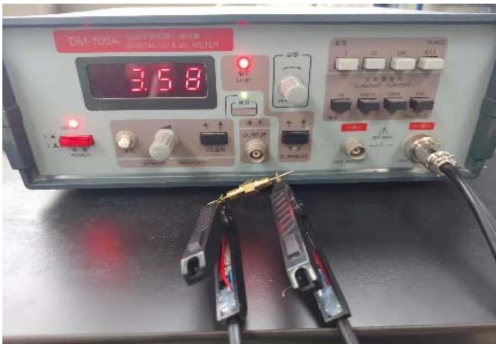
Figure 1. Connection resistance is measured using a